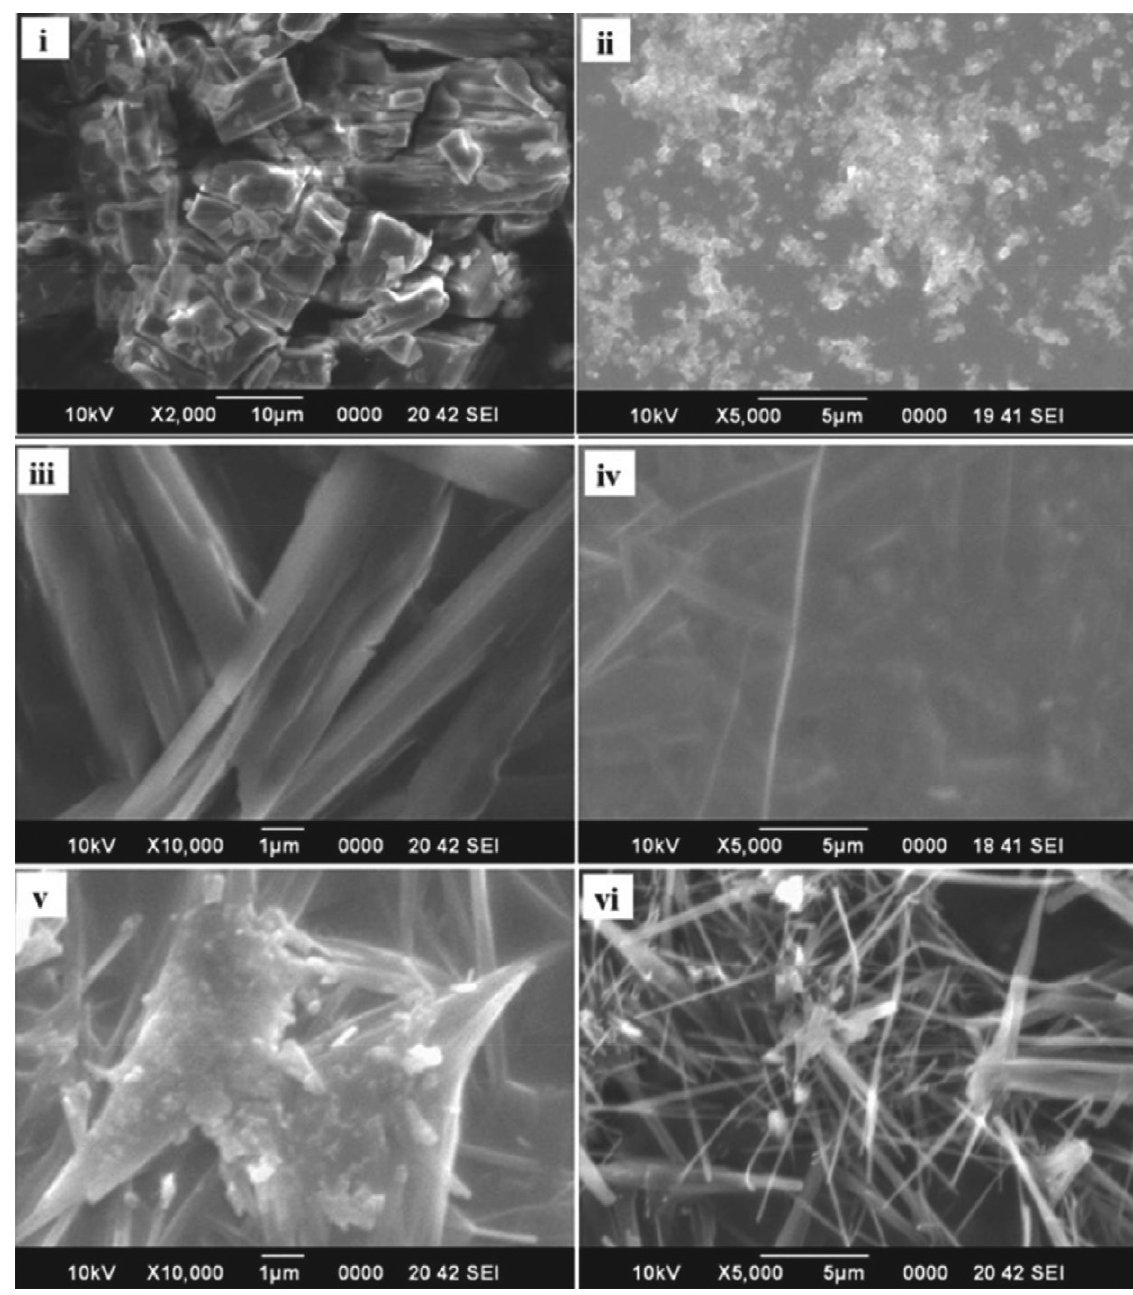
Figure 2. Scanning electron micrograph of pure DXM (magnification 2,000) (i); kaolin (magnification 5,000) (ii); films with kaolin (magnification 10,000) (iii), (magnification 5,000) (iv) of HPMC K100 LVCR; and films with kaolin (magnification 10,000) (v), (magnification 5,000) (vi) of HPMC K100 M